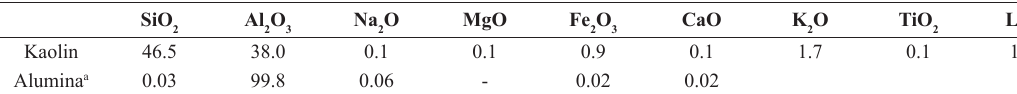
Table 1. Chemical composition of raw materials.